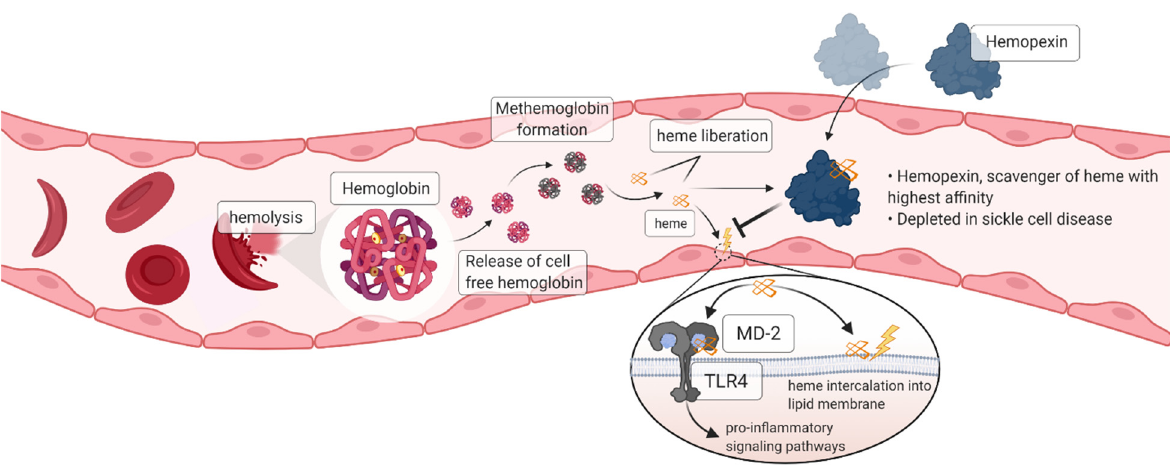
Figure 6. Current understanding of hemopexin Mode of Action. In patients suffering from sickle cell disease, repeated sickling cycles result in increased hemolysis. Hemolysis by-products such as heme leads to endothelial cell activation and oxidative stress, in part through the heme/TLR4/MD-2 signaling pathway and heme intercalation into cell membranes. Hemopexin, the natural scavenger of heme, is rapidly depleted under chronic hemolysis. Exogenous hemopexin supplementation proven to be effective in preventing endothelial cell activation in vitro and beneficial in the acute setting in vivo to reduce and resolve vaso-occlusion through its effect on heme neutralization and removal, induction of HO-1, and prevention of endothelial cell inflammatory responses (created with BioRender.com, accessed on 19 January 2022).